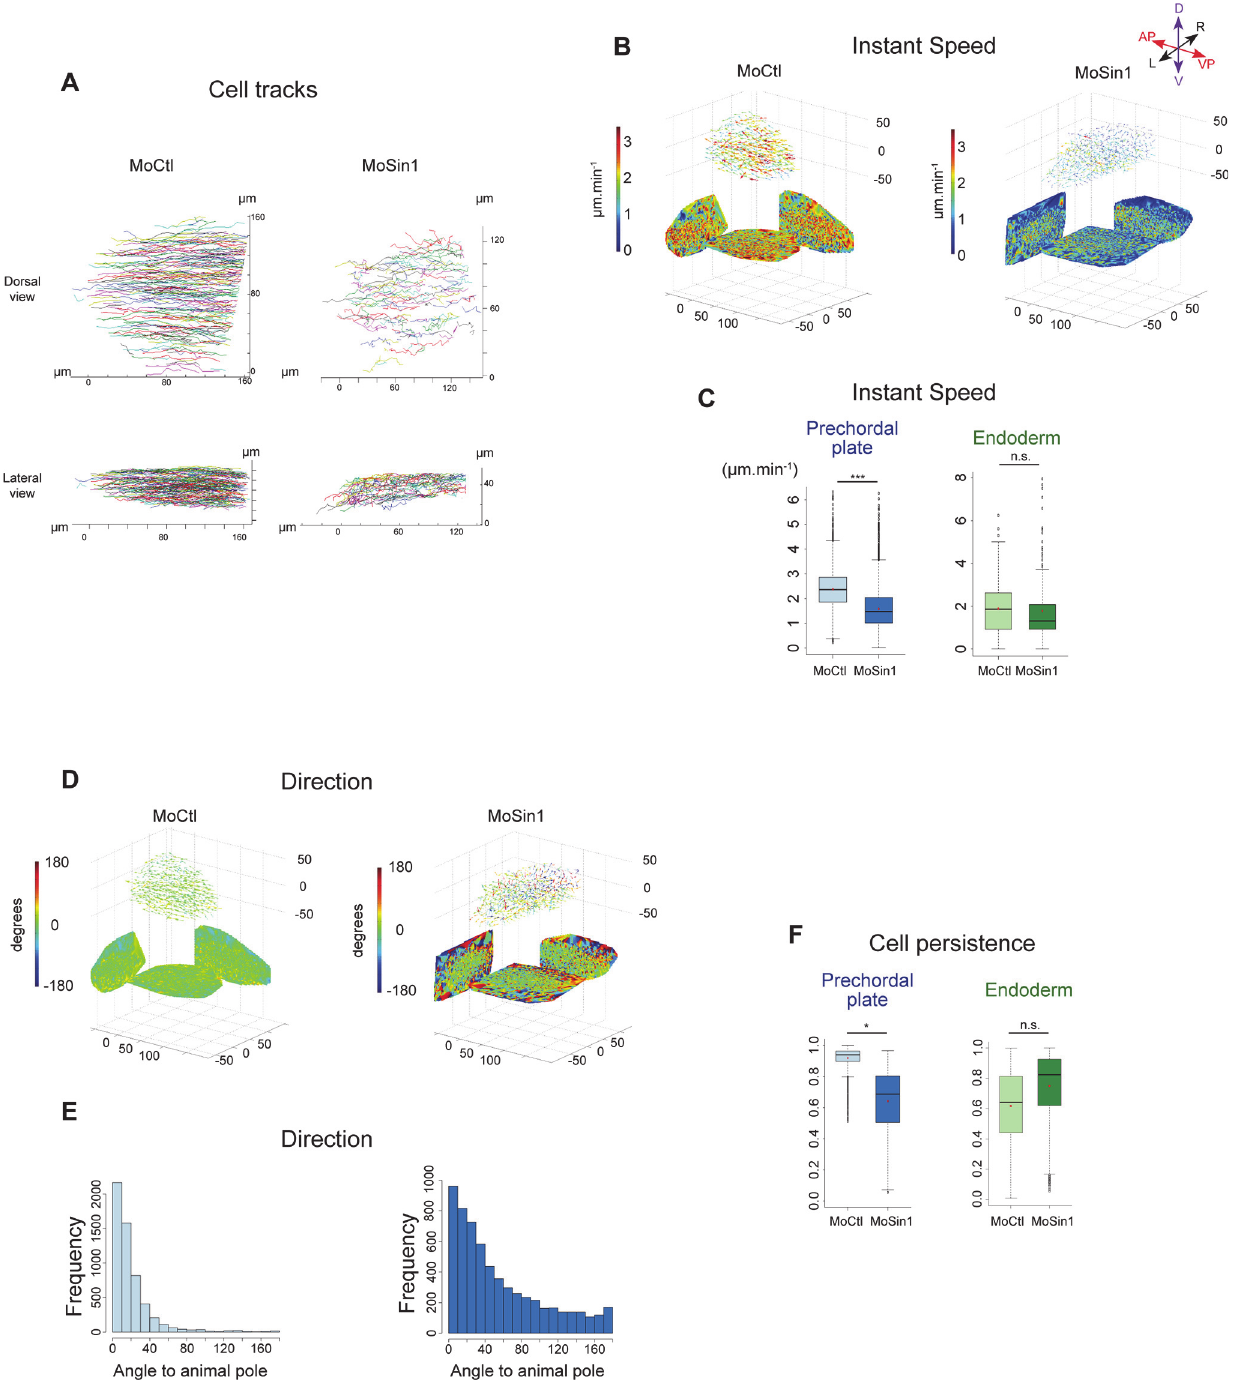
Fig 3. In absence of sin1 , prechordal plate cells migrate slower and less persistently. (A) Tracks of prechordal plate nuclei in one representative embryo injected with a control morpholino or the sin1 morpholino, dorsal and lateral views (see S2 Movie and S3 Movie). (B) Field of instantaneous speed in the prechordal plate (see Materials and Methods). Arrows indicate speed vectors, speed norm is colour-coded. Two-dimensional projections on the three planes have been plotted. (C) Instantaneous speed (measured on 2-minute intervals) of prechordal plate cells and endodermal cells, in embryos injected with the sin1 morpholino or a control morpholino. Speed of prechordal plate cells is reduced in sin1 loss of function, whereas speed of endodermal cells, used as a control, is not affected. (D) Same as in B, but colour-coding represents the direction of the movement. (E) Orientation of cell movements relative to the direction of the animal pole. In absence of sin1 , cell movements are less directed towards the animal pole. (F) Cell persistence, measured as the ratio between the net displacement of the cell and the total length path over ten minute intervals. In absence of sin1 , persistence of prechordal plate cells is reduced whereas persistence of endodermal cells is